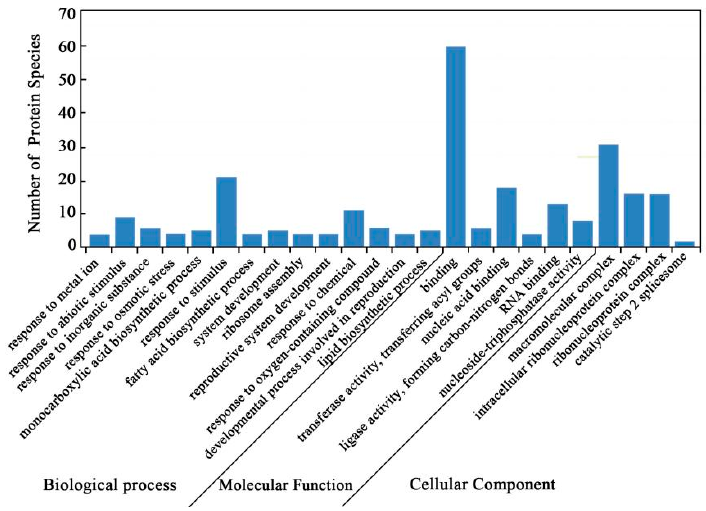
Figure 2. GO annotation of DAPS identified by the iTRAQ.